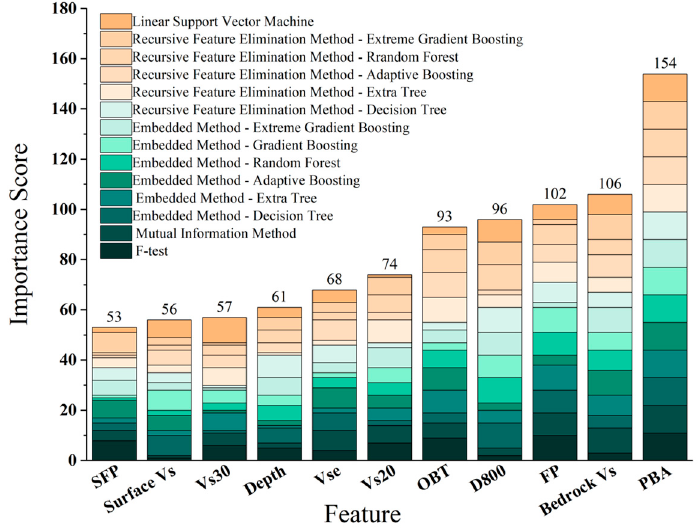
Figure 2. Importance score of features.